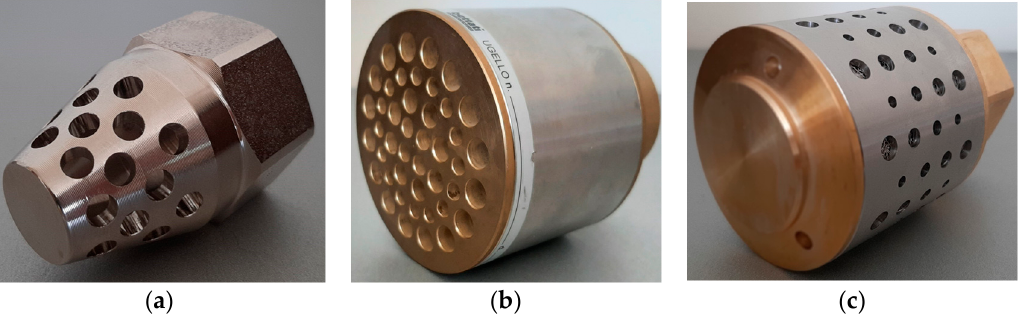
Figure 3. Photos of the nozzles employed in the experiments: ( a ) standard; ( b ) silent nozzle for the discharge of inert gases; ( c ) silent nozzle for the discharge of halocarbon compounds (low ceiling height).